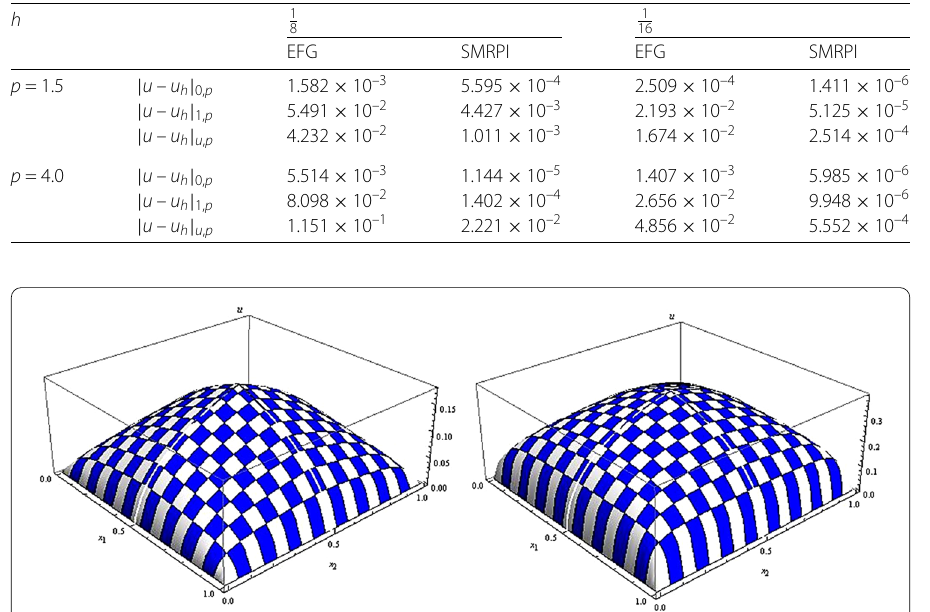
Figure 6 Graphs of the SMRPI solution and the error with h = 1/32 and p = 1.1,2 for Example 4